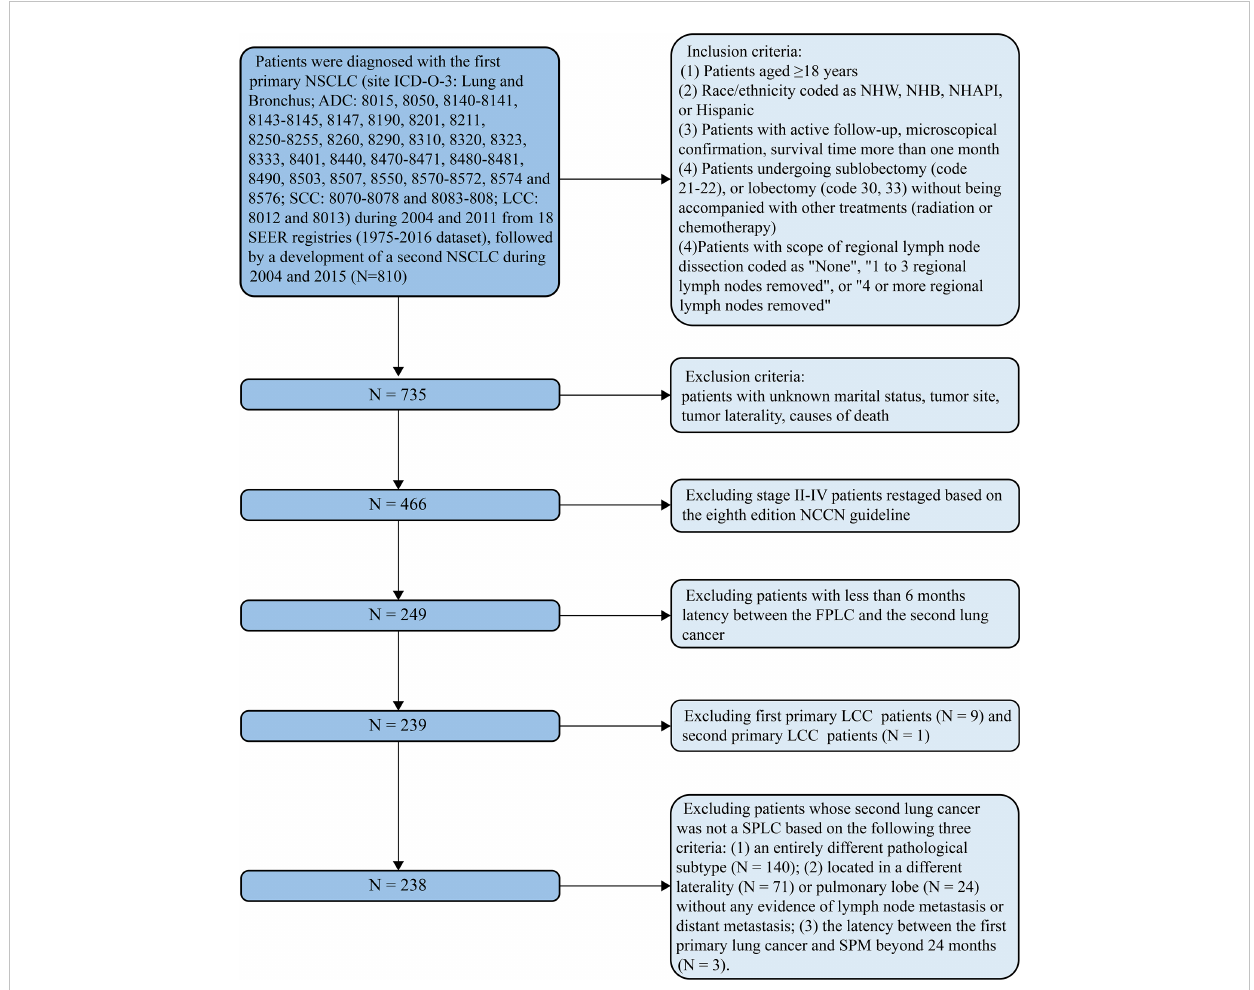
FIGURE 1 Flow diagram described the screening process in the SEER database, containing the inclusion and exclusion criteria. ADC, adenocarcinoma; LCC, large cell carcinoma; FP, fi rst primary lung cancer; NCCN, National Comprehensive Cancer Network; NHAPI, non-Hispanic Asian/Paci fi c Islander; NHB, non-Hispanic Black; NHW, non-Hispanic white; NSCLC, non-small cell lung cancer; SCC, squamous cell cancer; SEER, Surveillance Epidemiology and End Results; SP, second primary non-small cell lung